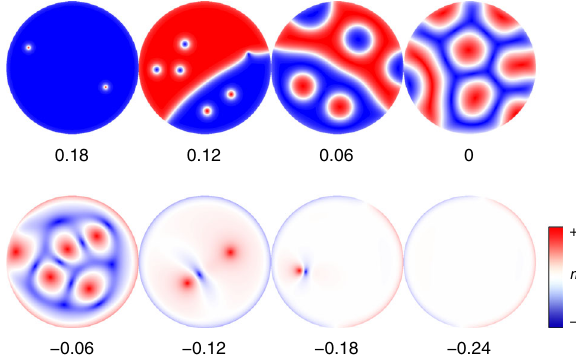
Fig. 3 Evolutions of spin textures under the modulations of magnetic anisotropy. Relaxed magnetic con fi gurations under various K